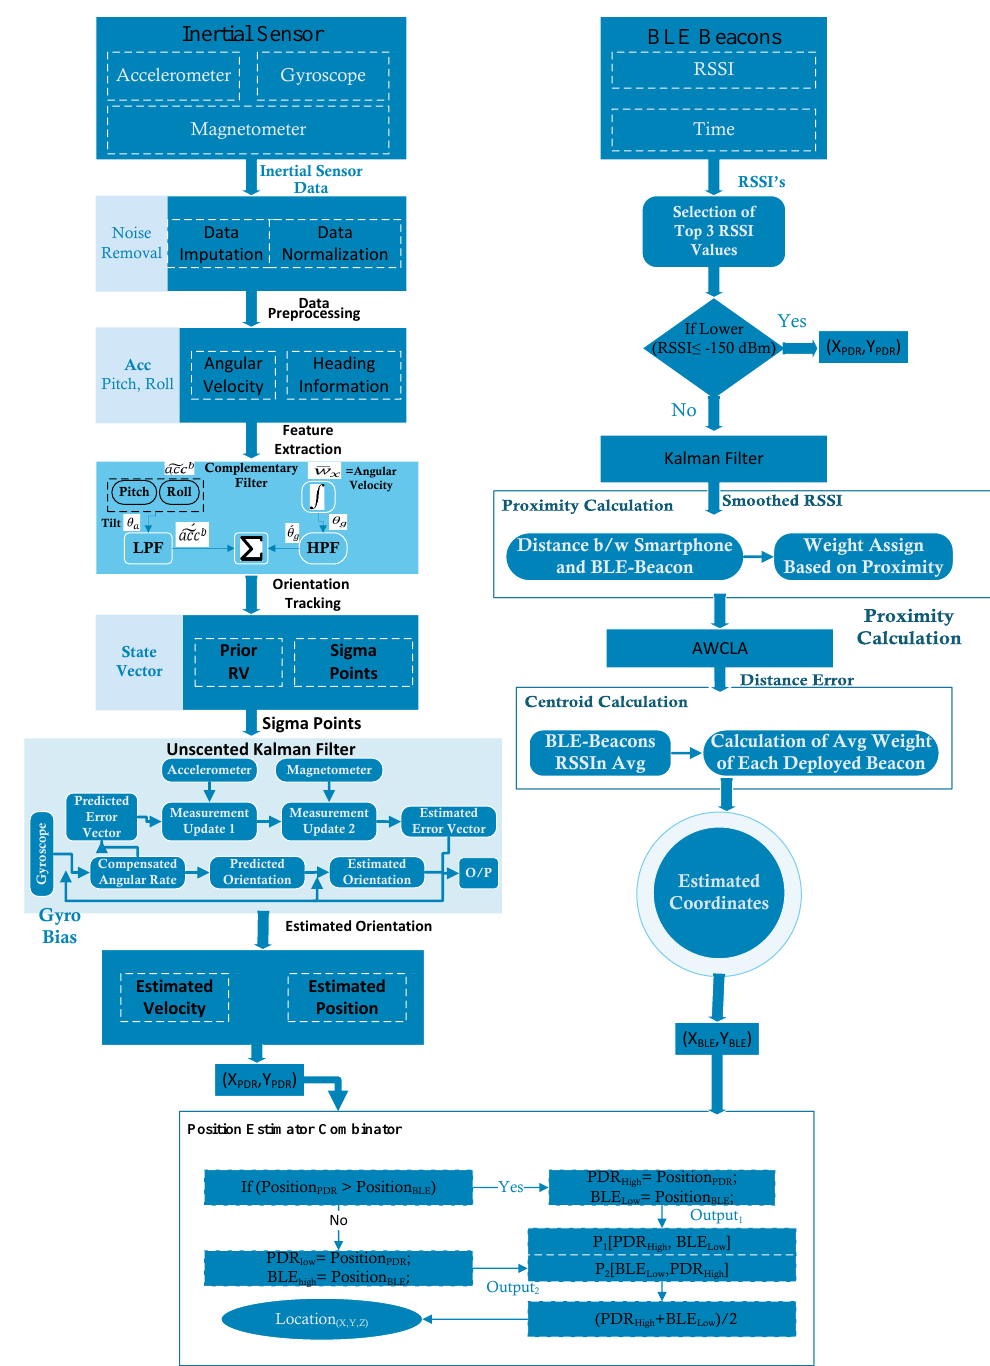
Figure 1. Hybrid position error compensation mechanism For indoor